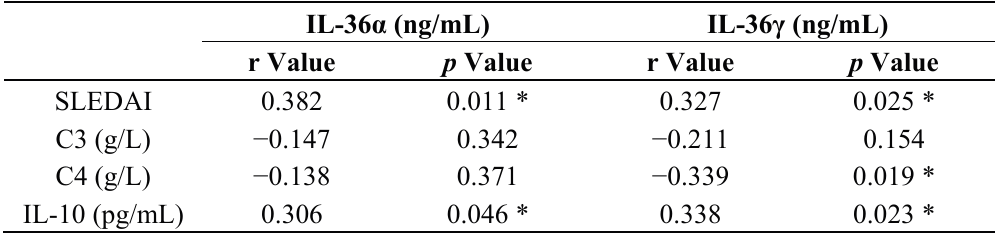
Table 2. Correlations of plasma IL-36 concentrations with SLE disease activity and